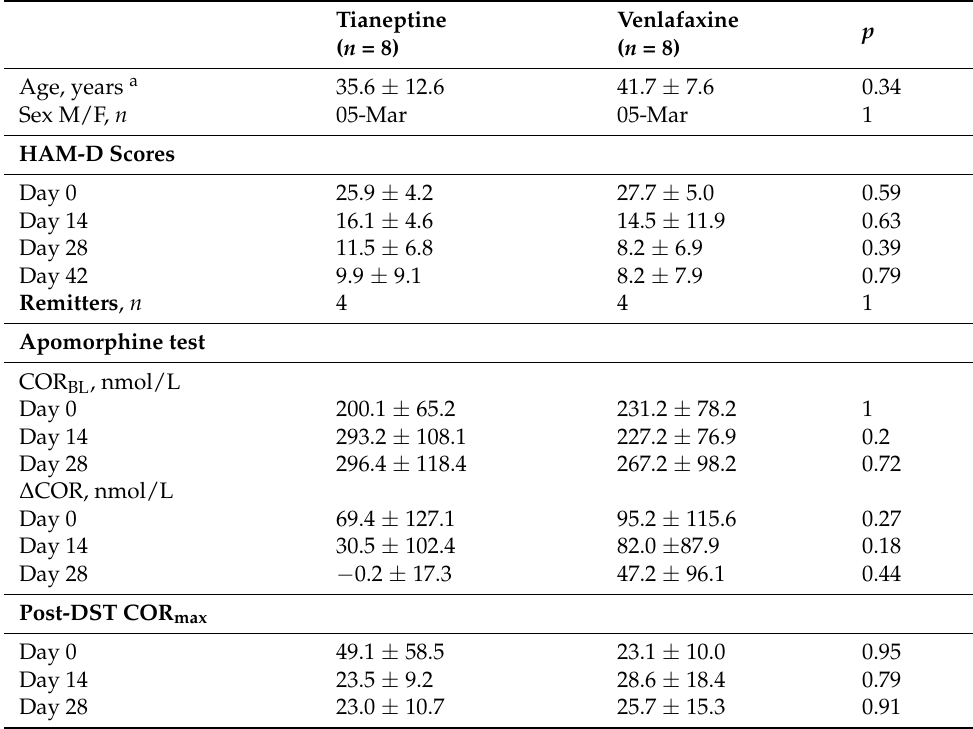
Table 1. Bio-clinical data on patients treated with either tianeptine or